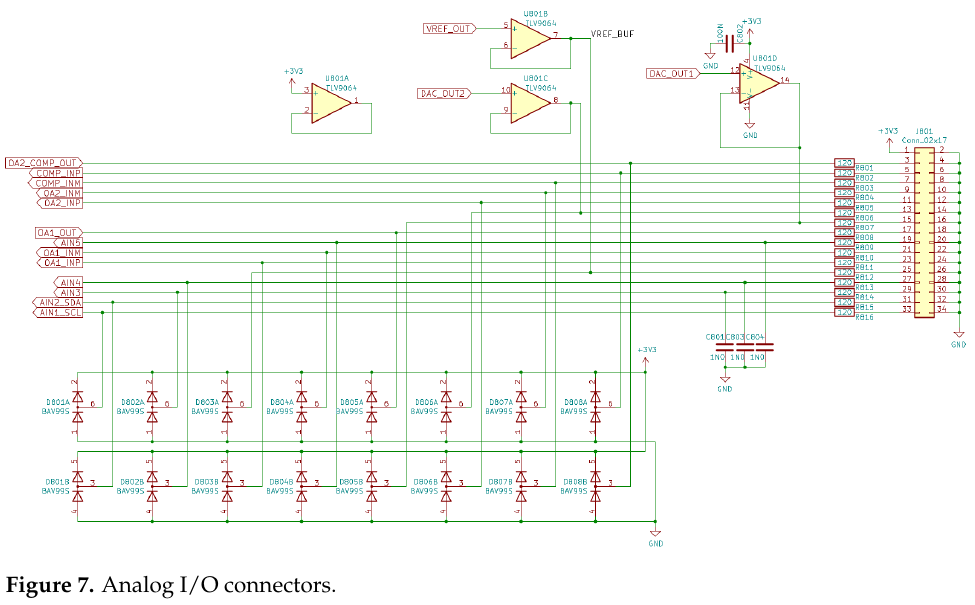
Figure 7. Analog I/O connectors.